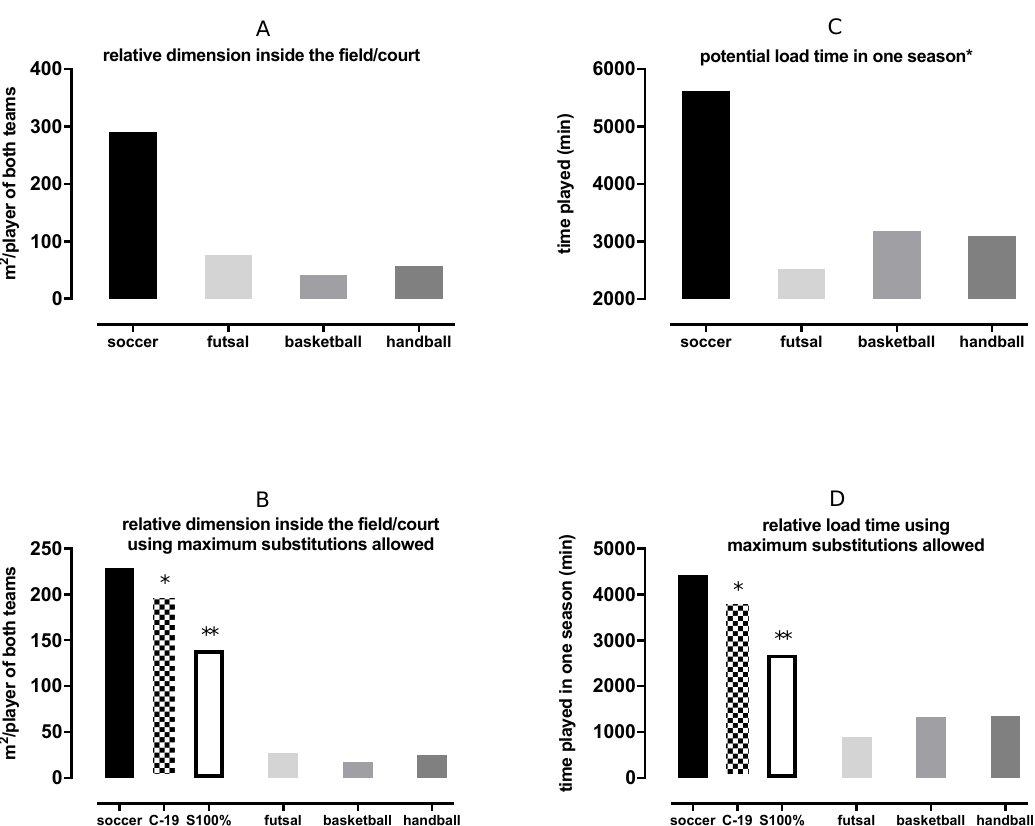
Figure 3. Proportion between dimensions of the fields/courts ( A , B ), considering two opposing teams (e.g., soccer 11 vs. 11 = 22 total). Panel ( A ) shows values related to the regular number of players on the field/court. Panel ( B ) shows the values using the maximal players involved in a game according to the regular rule for substitutes (see E in Table 1); * C-19 means the increased maximum substitutions allowed for soccer (from 3 to 5), due to postponing the calendar caused by the COVID-19 pandemic; ** S100% represents a hypothetical simulation if soccer could make unlimited substitutions (i.e., using total players available in a game (i.e., 23 each team)). So, 6400 m 2 (soccer area)/46 players (23 × 2 teams) = 139 m 2 /player. Panel ( C ) shows a ratio between total game time X number of matches (e.g., soccer 90 min × 62.5 matches/season [Table 3] = ~5625 min/season). Panel ( D ) presents the load time using the maximum substitutions allowed in each sport. Note that for soccer we added the C-19 * and S100% ** simulations to equate (like panel B explanation).